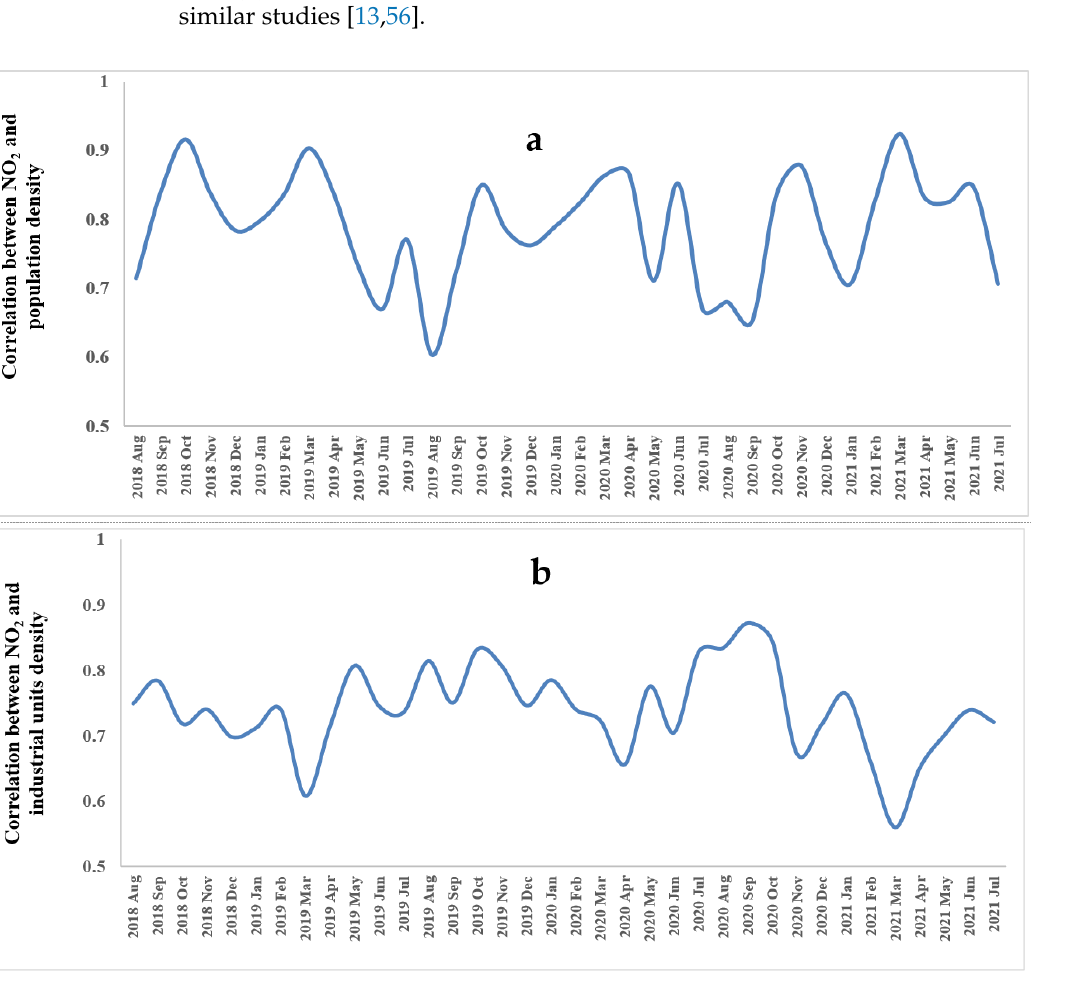
Figure 8. ( a ) Correlation between population density and tropospheric NO 2 columns concentration (10 15 molecules cm − 2 ); ( b ) correlation between industrial units’ density and tropospheric NO 2 columns concentration (10 15 molecules cm − 2